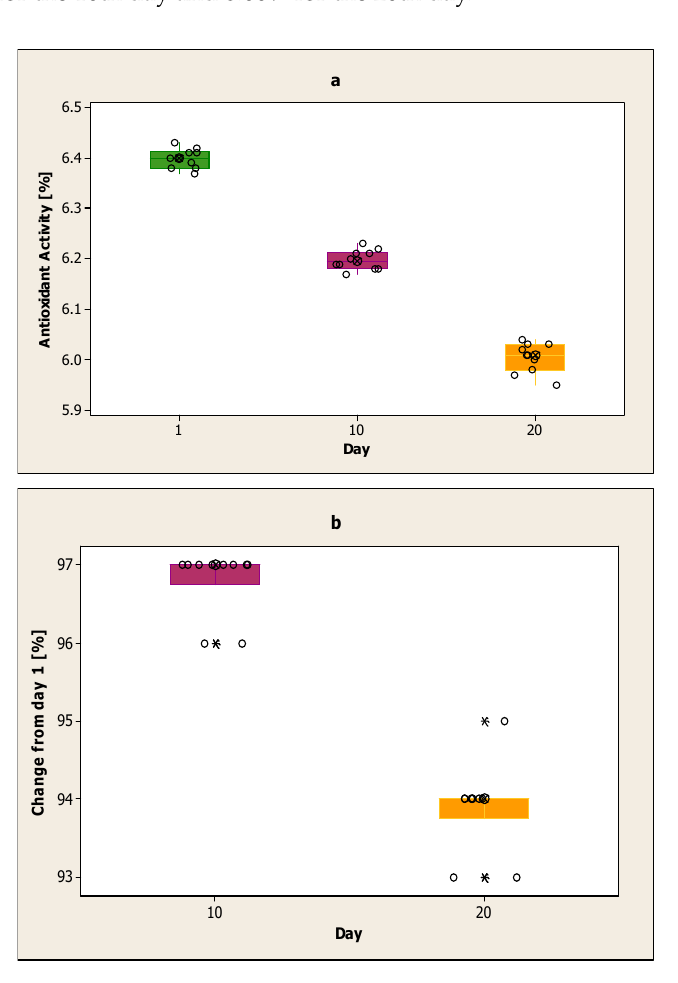
fennel oil encapsulated in sodium alginates on the first day, the 10th day and the 20th day; ( b ) Decline